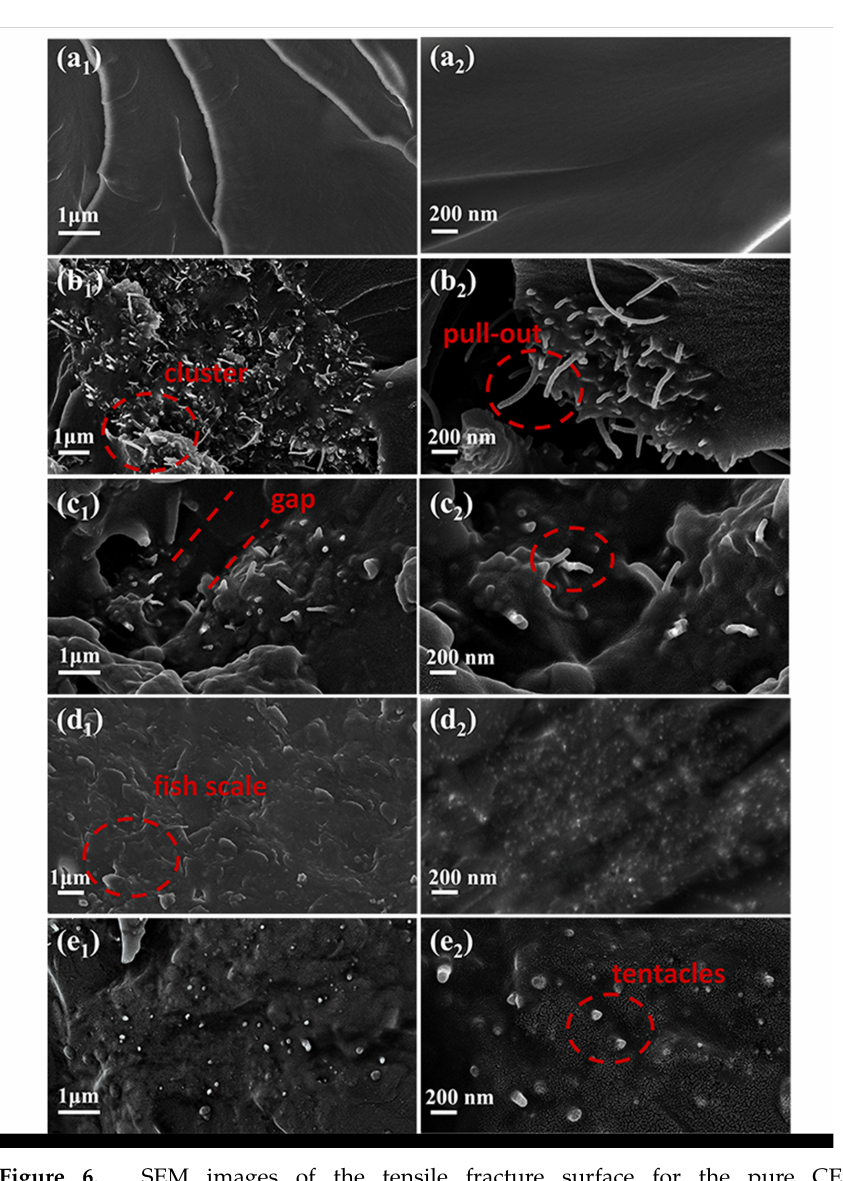
Figure 6. SEM images of the tensile fracture surface for the pure CER-E network ( a 1 , a 2 ), CER-E/MWCNTs ( b 1 , b 2 ), CER-E/uMWCNTs ( c 1 , c 2 ), CER-E/Eu complex ( d 1 , d 2 ), CER-E/ETP-uCNTs ( e 1 , e 2 ).